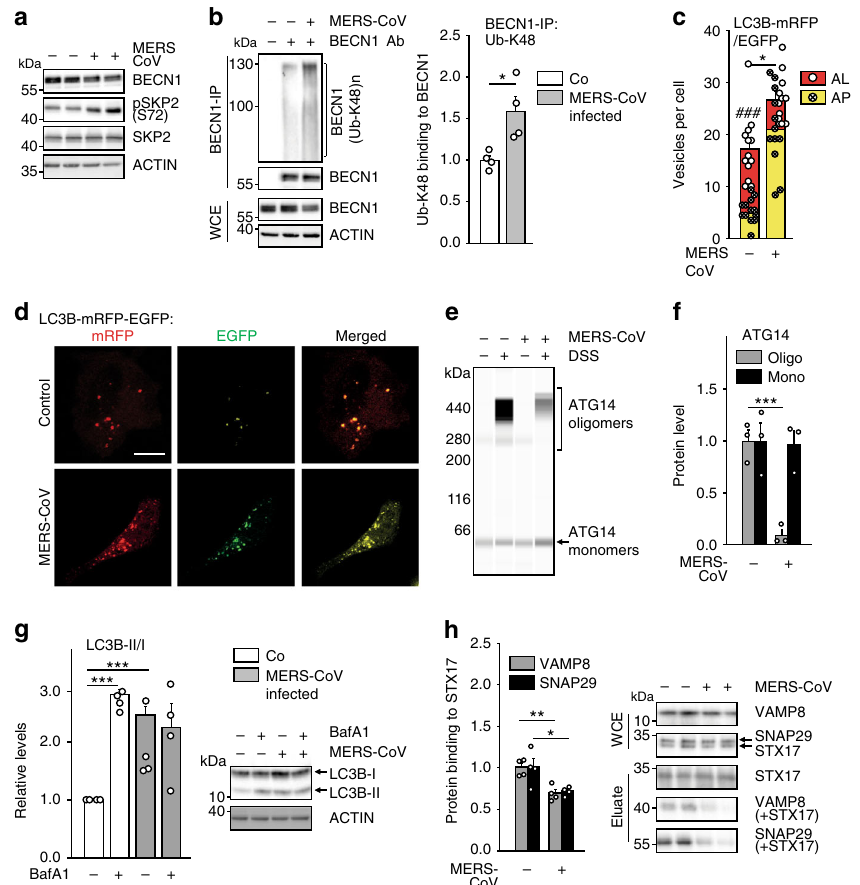
Fig. 6 MERS-CoV blocks autophagic fl ux. a MERS-CoV decreases BECN1 and increases pSKP2. VeroB4 cells were infected with MERS-CoV (MOI = 0.001) or mock-infected and harvested 48h later. Representative western blots are shown, quanti fi cation in Supplementary Fig. 3a, b. b MERS-CoV increases K48- linked poly-ubiquitination of BECN1. BECN1 was immune-precipitated from cell extracts 48h p.i. and its ubiquitination determined by a ubiquitin K48 linkage speci fi c antibody. c , d MERS-CoV blocks fusion of AP with lysosomes. VeroB4 cells were transfected with tandem fl uorescent-tagged LC3B (mRFP and EGFP) and infected with MERS-CoV (MOI = 0.001). Twenty-four hours later, cells were fi xed and analyzed for fl uorescence. Vesicles with both green and red fl uorescence (autophagosomes, AP) and with red fl uorescence only (autolysosomes, AL) were counted. d , representative images, scale bar 25 µ m. e , f MERS- CoV decreases ATG14 oligomerization. VeroB4 cells were infected with MERS-CoV (MOI = 0.001), cross-linked with disuccinimidyl suberate (DSS, 75 µ M) 48 h p.i. for 30min and harvested. ATG14 homo-oligomerization was examined after western blotting (ProteinSimple). g MERS-CoV decreases autophagic fl ux. VeroB4 cells were infected with MERS-CoV (MOI = 0.001) and incubated with ba fi lomycin A1 (BafA1, 0.1 µ M) for 2h before samples were taken at 48h p.i.. The ratios of LC3B-II/I were determined by western blotting. h MERS-CoV affects SNARE protein interactions. VeroB4 cells were infected with MERS- CoV (MOI = 0.001), cross-linked with disuccinimidyl suberate (DSS, 75 µ M) 48 h p.i. for 30 min and harvested. The SNARE complex protein STX17 was immunoprecipitated and the eluate was probed for interacting VAMP8 and SNAP29 by western blotting (the quanti fi cation represents the bands detected at the combined molecular weights of the cross-linked proteins, i.e. STX17 + VAMP8 and STX17 + SNAP29). In all panels, error bars denote the standard error of the mean. derived from n = 3 biologically independent experiments for b , f , g , h , and n = 13 (control) or n = 12 (CoV) different cells for c . WCE = whole cell extract of vehicle exposed cells, i.e. no cross-linking. * p < 0.05, ** p <0.01, *** p < 0.001 ( t -test in b , c , f , h , two-way ANOVA in g , details in Supplementary Tables 1, 2). Source data and blot collections are provided as a Source Data fi